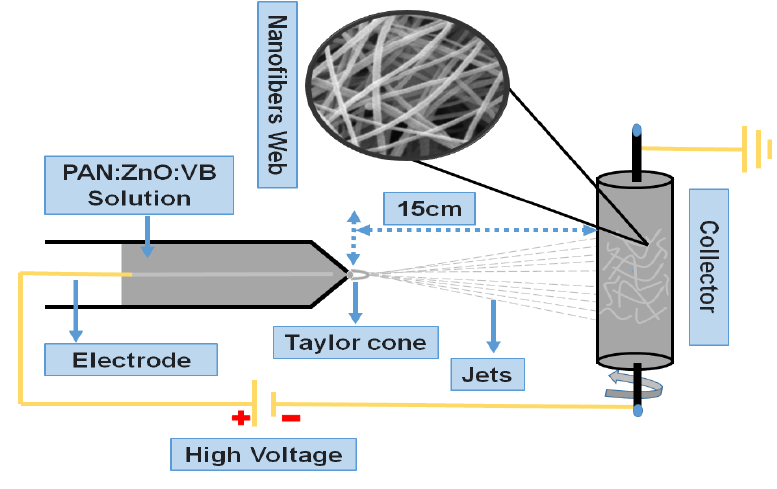
Figure 1. Illustration scheme of fabrication of antiviral nanofibers.